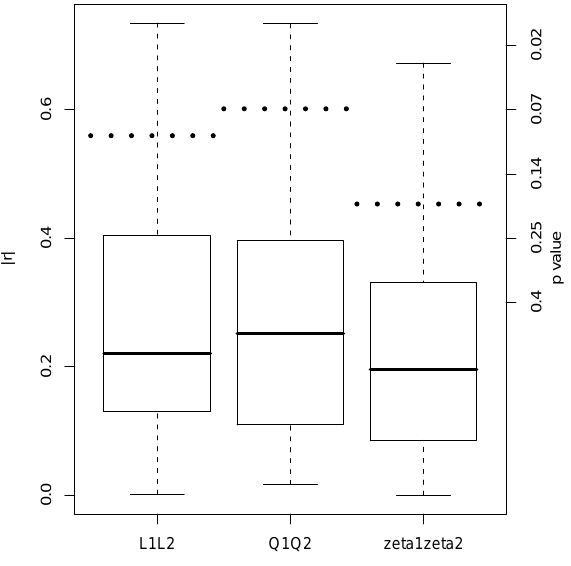
Fig. 6. Distribution of absolute values of correlation | r | between L 2 (t) , Q 2 (t) and ζ 2 (t) transforms of two random AR(1) pro- cesses with the respective variance and autocovariance of ECA&D European temperatures and geomagnetic field from Eskdalemuir. The box and whisker plots indicate the 25, 50 and 75th quantiles q (boxes). The upper whisker corresponds to: min ( max ( | r | ),q 50 + 1 . 5 × (q 75 − q 25 )) . The right hand vertical axis shows the p values for r = 0 . 3 to 0.7, with increments of 0.1, corresponding to a null hypothesis of no correlation and n = 10 degrees of freedom. The horizontal thick dotted lines indicate the 90th quantile of | r |